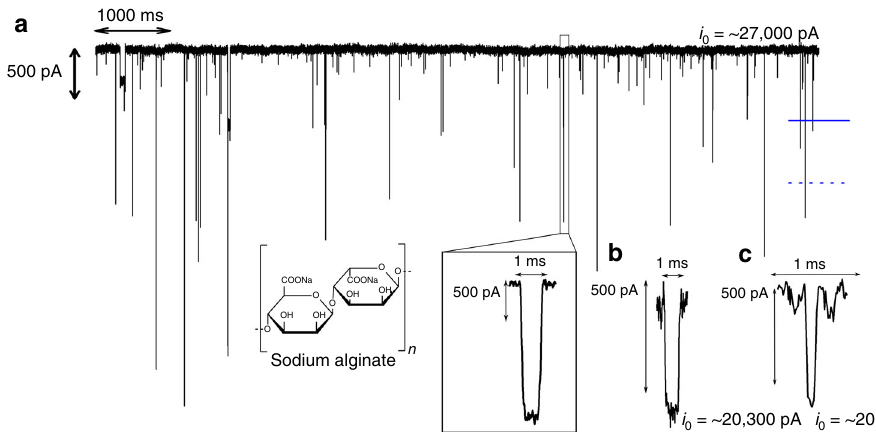
Fig. 2 Representative nanopore current trace and events from sodium alginate samples from two different sources. a A representative segment of an A1 - induced current trace using a ~21 nm-diameter pore; the solid blue line marks the most frequent event level, i b , and the blue dashed line is its mean across all events. The magni fi ed current event is from the same trace. b A2 - and c enzyme-digested- A2 -associated single events through a ~22 nm-diameter pore. All currents were measured in response to a − 200 mV